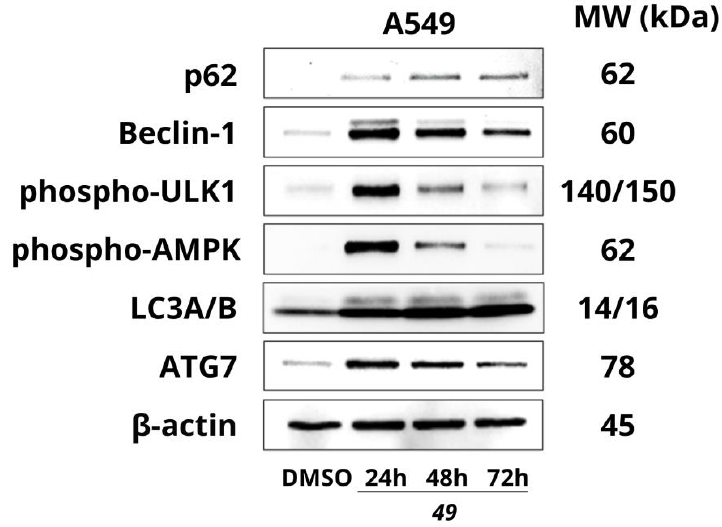
Figure 4. Western blot analysis of autophagy-related proteins in compound 49 -treated A549 cells.